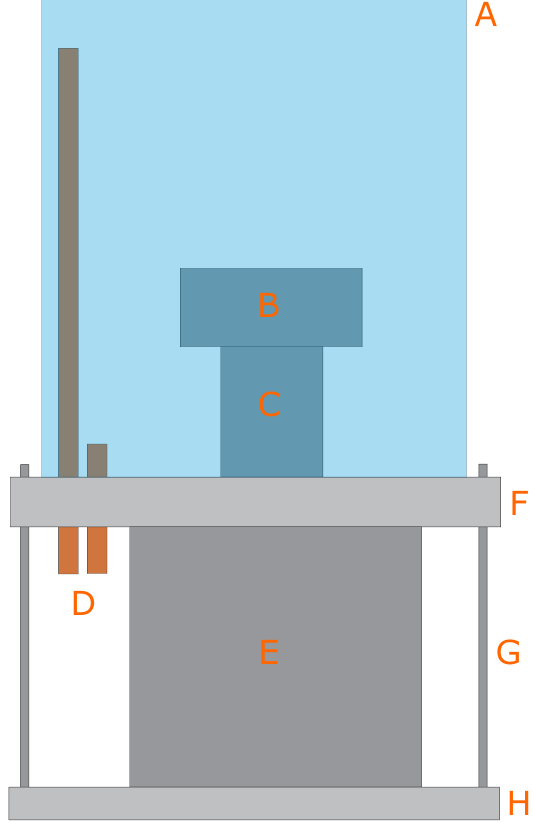
Figure 2. Scheme of the EC: (A) acrylic chamber, (B) AFM head, (C) piezoelectric tube, (D) copper tubes (inlet and outlet of gases), (E) AFM base, (F) aluminum ring, (G) threaded rods, and (H) alu- minum